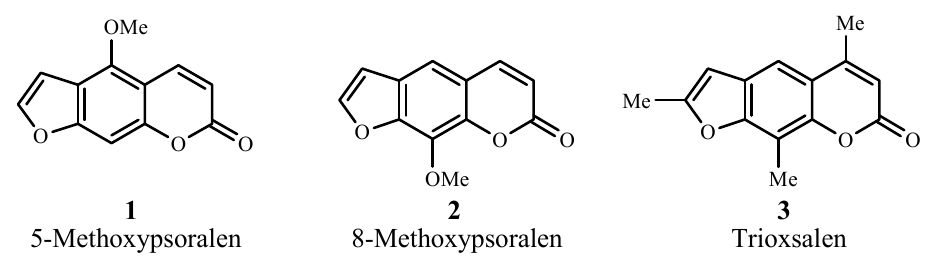
Figure 1. Examples of psoralen photosensitizers.